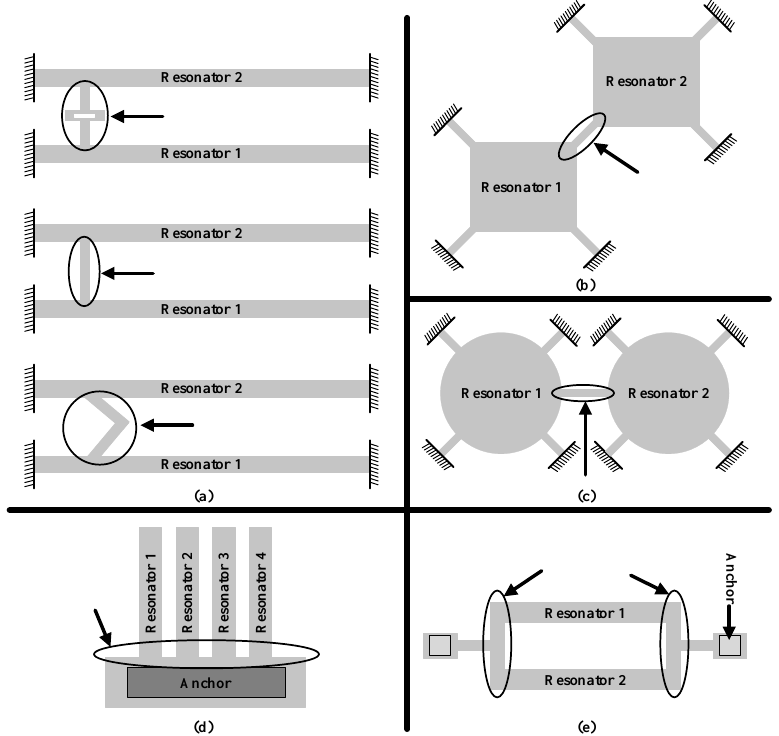
Figure 6. Structures of mechanical coupling of resonators. ( a ) Beam coupled; ( b ) Corner coupled; ( c ) Middle side coupled; ( d ) Overhang coupled; and ( e ) Double-end coupled. Reproduced with permission from [55]. Copyright © 2014 by M. Sadegh Hajhashemi.